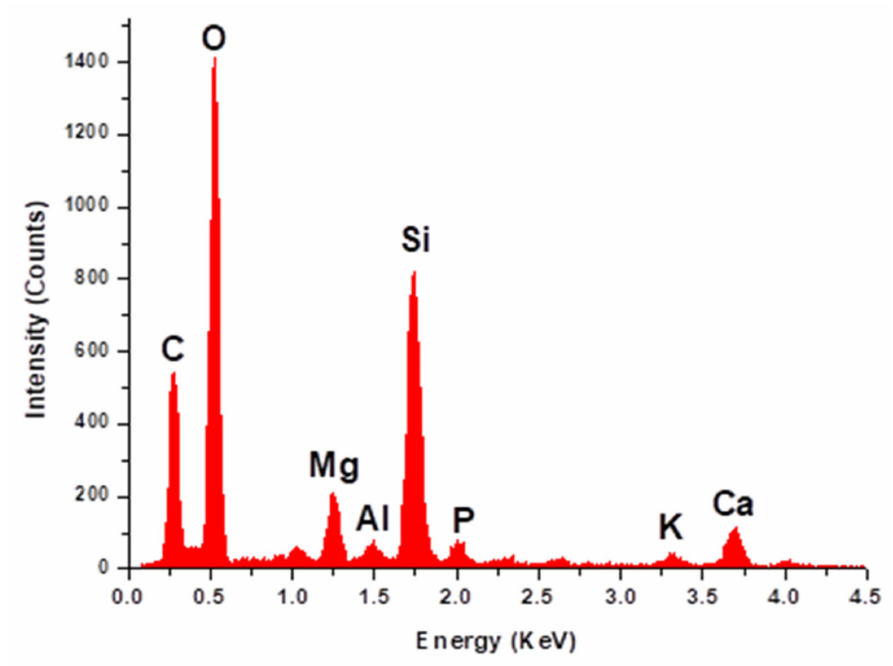
Figure 2. EDX analysis of sheep dung